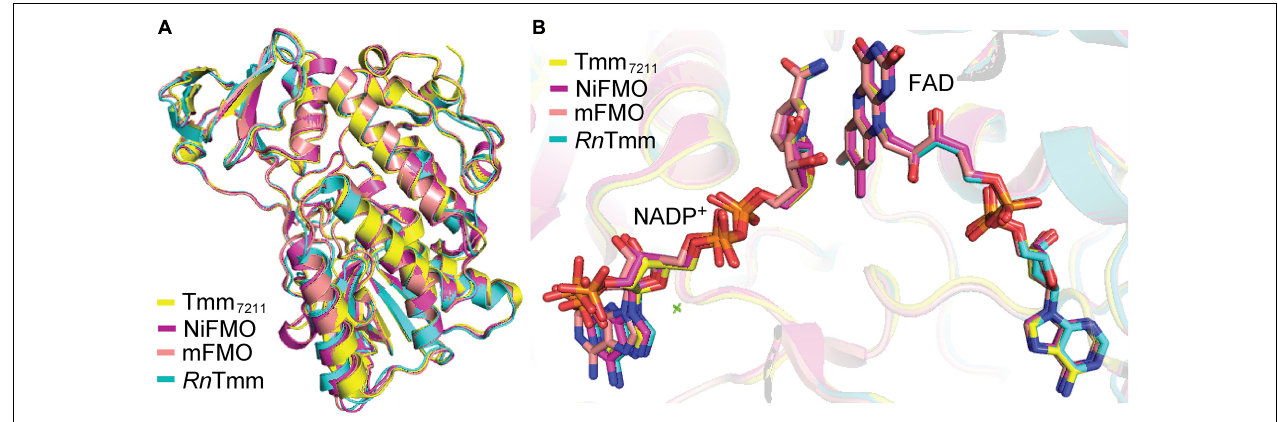
FIGURE 6 | Structural comparisons between Tmm 7211 and three other reported bacterial FMOs. (A) Superimposition of the structures of Tmm 7211 , NiFMO (PDB code: 6HNS), mFMO (PDB code: 2VQ7) and Rn Tmm (PDB code: 5IPY). Structures of Tmm 7211 , NiFMO, mFMO and Rn Tmm are colored in yellow, purple, salmon and cyan, respectively. (B) The locations of the NADP + and FAD in the four structures. The NADP + and FAD molecules are shown as sticks.